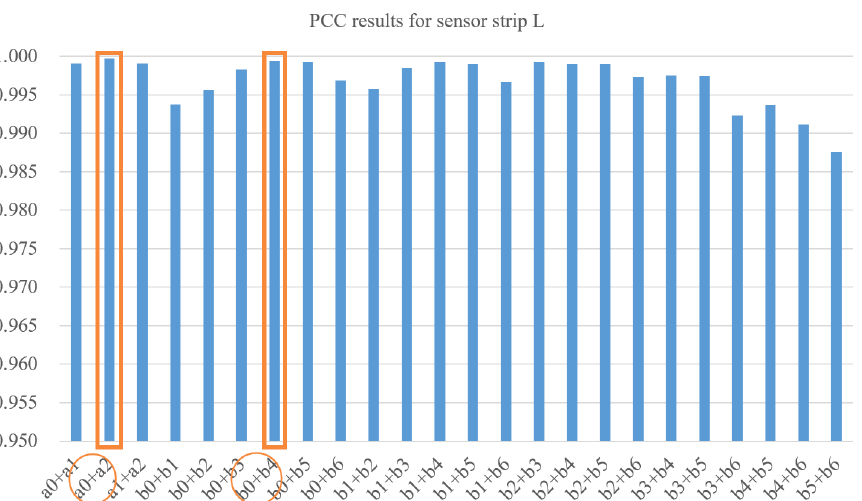
Figure 9. Results for selecting two sensors in dataset L . Orange circles indicate the best choices for each cluster.